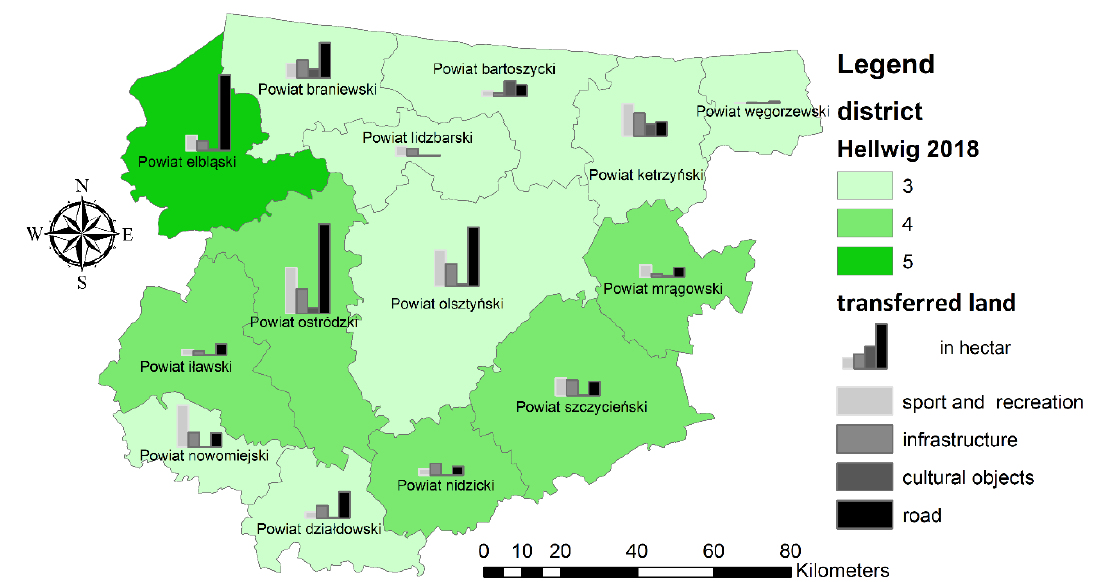
Figure 5. Social development classes for 2018 compared with the area of land transferred for various purposes. Data for districts.